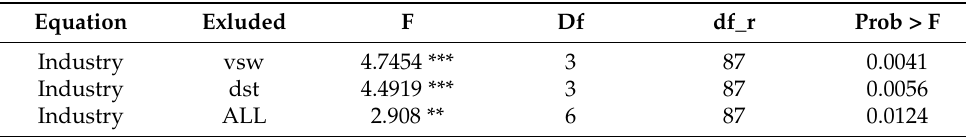
Table 6. Space weather and electricity consumption of the industry sector.